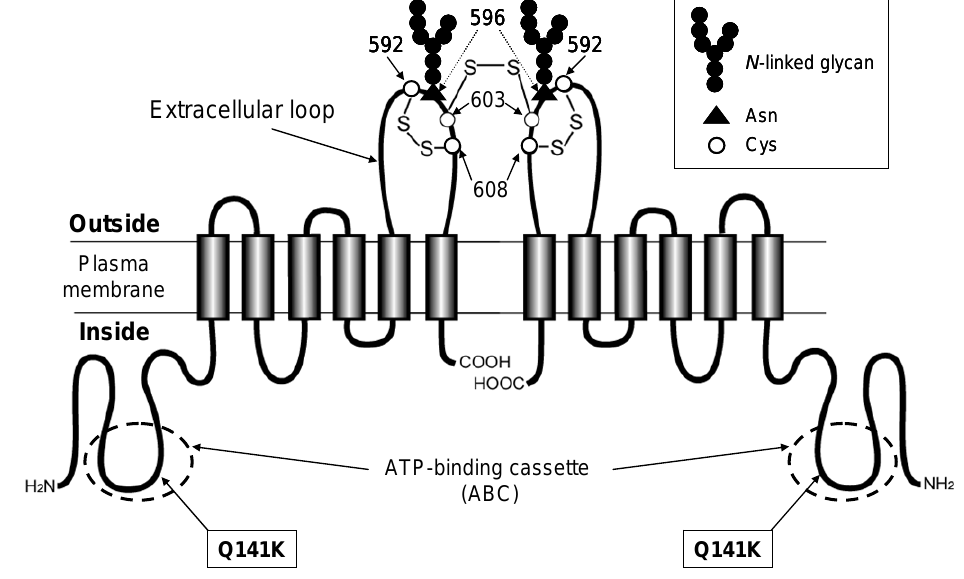
Lys (Q141K) in the intracellular loop containing an ATP-binding cassette